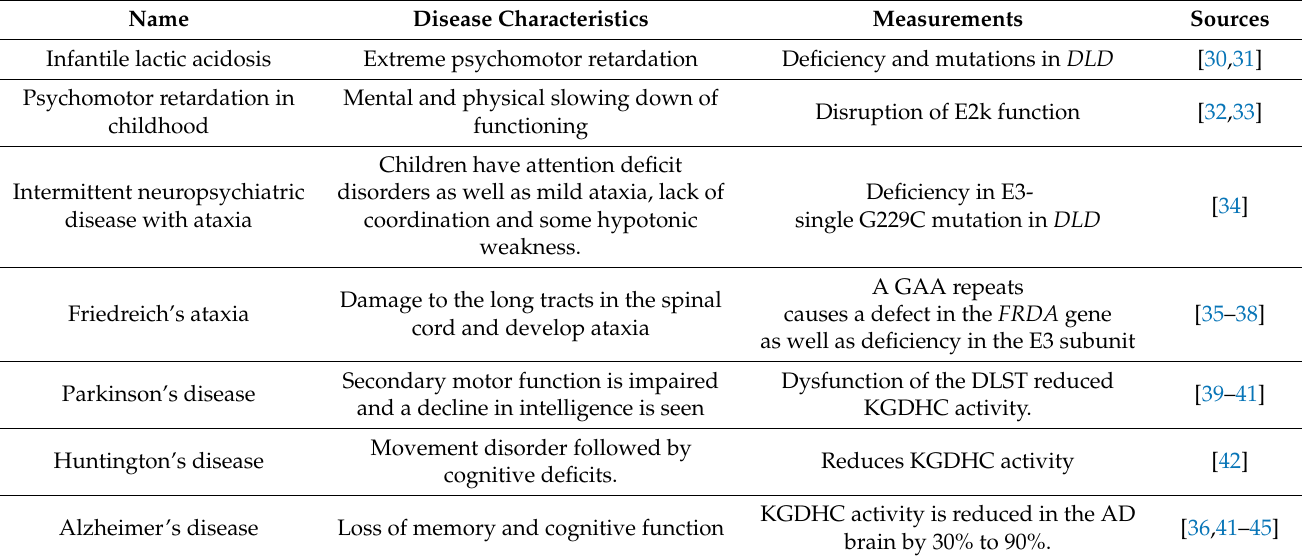
Table 1. Diseases related to disruption of